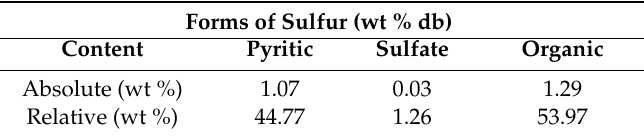
Table 6. The forms of sulfur in XF coal